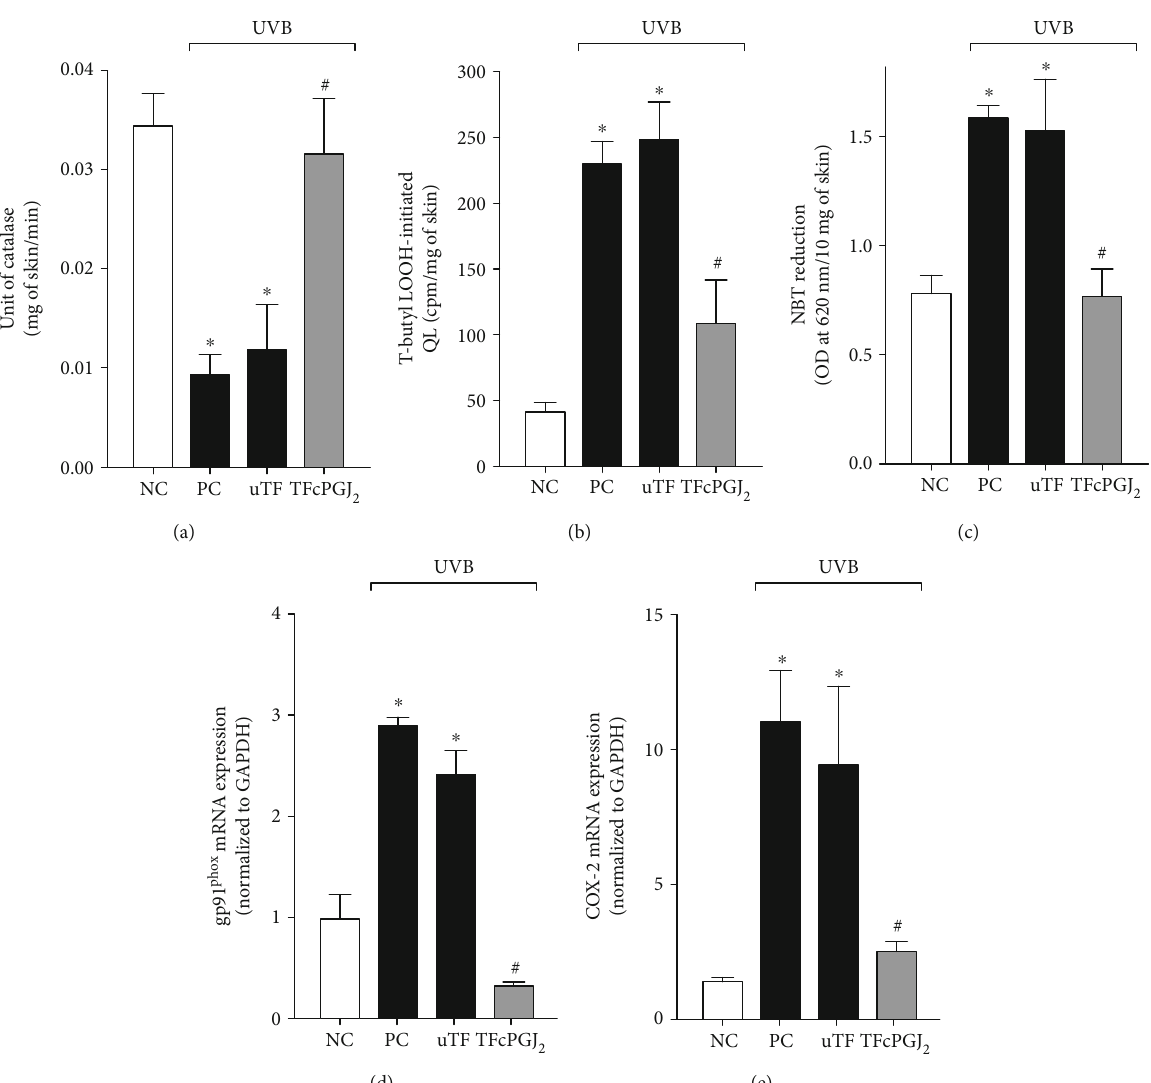
Figure 4: Topical formulation containing 15d-PGJ (TFcPGJ ) inhibits the depletion of endogenous catalase activity and the enhanced 2 2 production of lipid peroxides and superoxide anion as well as reduces gp91 phox and cyclooxygenase (COX-2) mRNA expression in UVB- irradiated skin. Catalase activity (a) was determined in samples collected 2 h after the end of irradiation. Lipid peroxidation (b) was measured by a chemiluminescence (QL) assay initiated by tert -butyl hydroperoxide (LOOH) on samples collected 4h after the end of irradiation. Superoxide anion production (c) was measured by the nitroblue tetrazolium (NBT) reduction test in samples collected 2 h after the end of irradiation. NADPH oxidase subunits gp91 phox (d) and COX-2 (e) were determined in samples collected 4h after the end of irradiation by RT-qPCR. NC: negative control; PC: positive control; uTF: unloaded topical formulation. Bars are means ± SEM of 6 mice per group and are representative of two separate experiments. One-way ANOVA followed by Tukey ’ s test. ∗ p < 0 : 05 versus the negative control group; # p < 0 : 05 versus UVB-stimulated